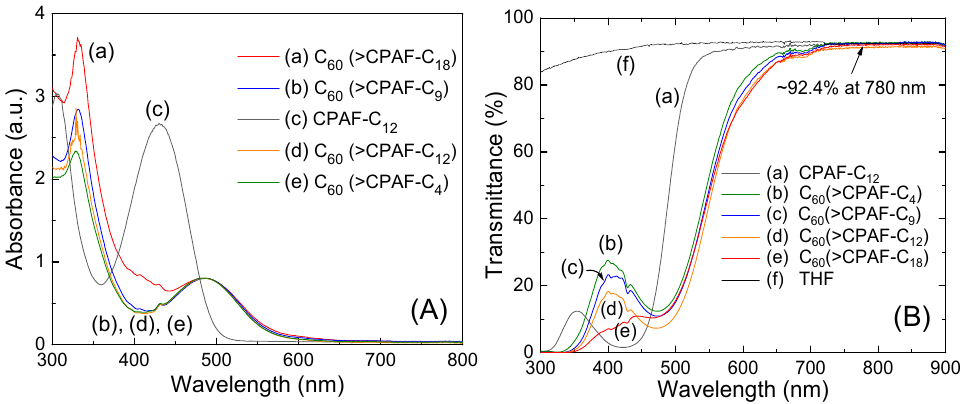
Figure 4. UV-vis ( A ) absorption (toluene, 1.0 × 10 − 5 M, normalized at λ max 486 nm) and ( B ) transmittance (THF, 2.0 × 10 − 5 M) spectra of CPAF-C 12 , 1 -C 4 , 1 -C 9 , 1 -C 12 , and 1 -C 18 with THF as the reference.